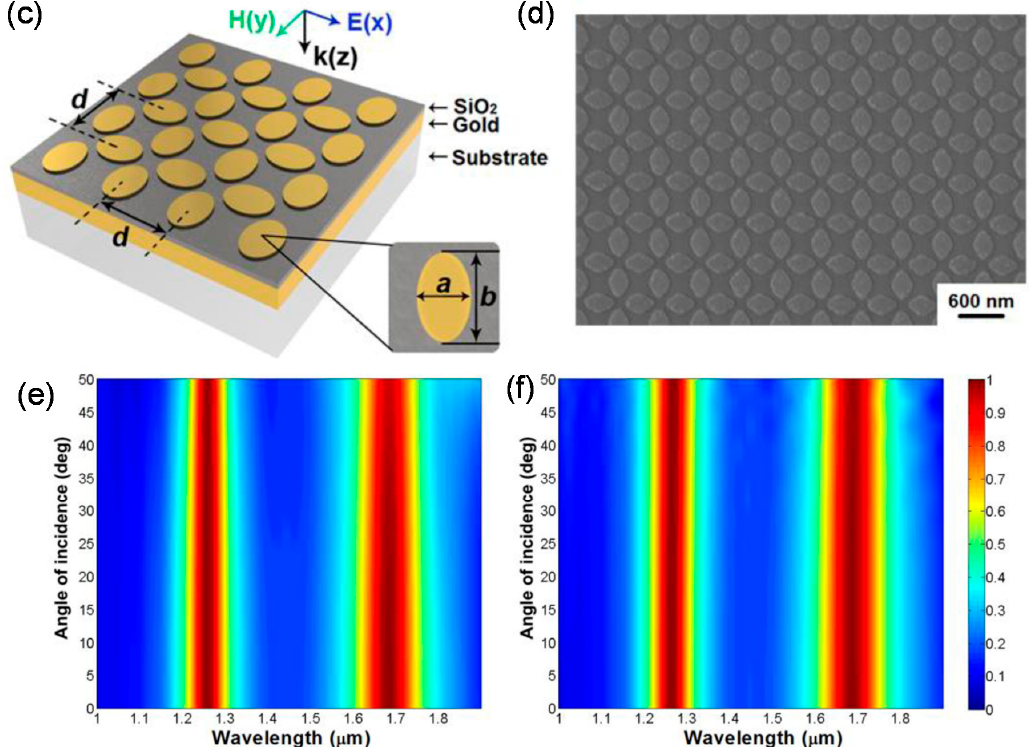
Figure 7. Schematic illustration of an MIM-PMA with asymmetric cross-shaped micropatches for dual-band operation. ( a ) Electric field distribution for modes I and II; and ( b ) the corresponding reflectance spectrum. ( c ) Schematic illustration and ( d ) SEM image of an MIM-PMA with an elliptical nanodisk array. Calculated absorbance for ( e ) TE and ( f ) TM modes. ( a , b ) are adapted with permission from Reference [52]. © 2012 American Chemical Society. ( c – f ) are adapted with permission